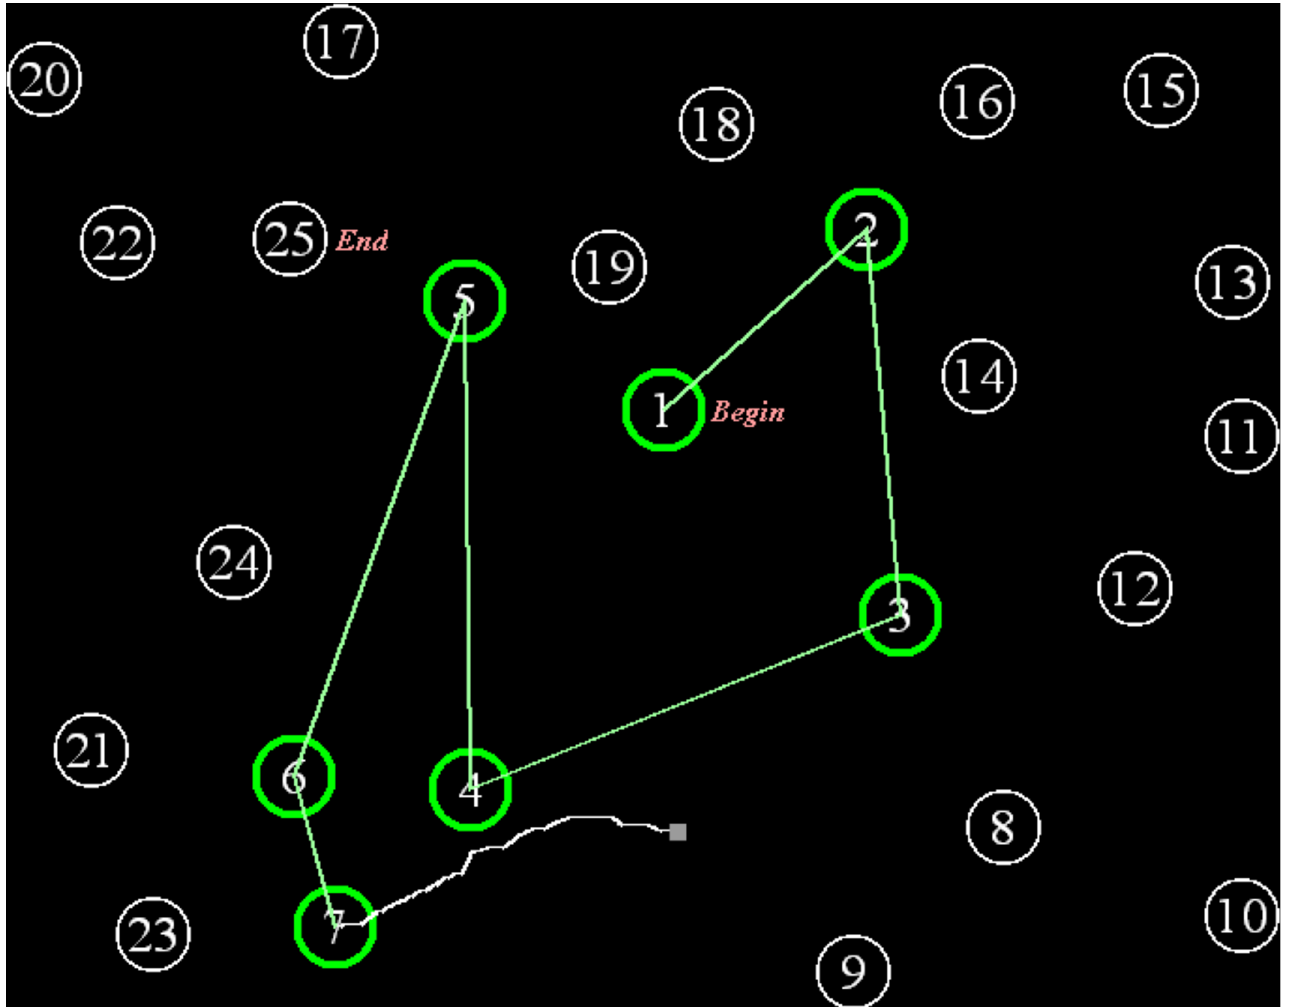
Fig 1. The C-TMT. The display as seen by a subject midway between connecting circles 7 and 8 on the C-TMT-A. As each circle was correctly connected, its color changed from white to green (e.g., circles 1 – 7). The current path between circles was shown in white (e.g., between 7 and 8), but was replaced by a straight green line as each segment was